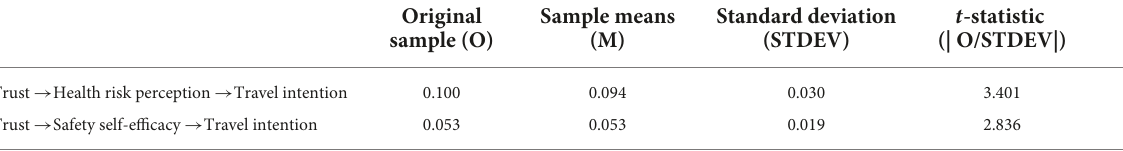
TABLE 6 Bootstrapping results for test of mediation effects.